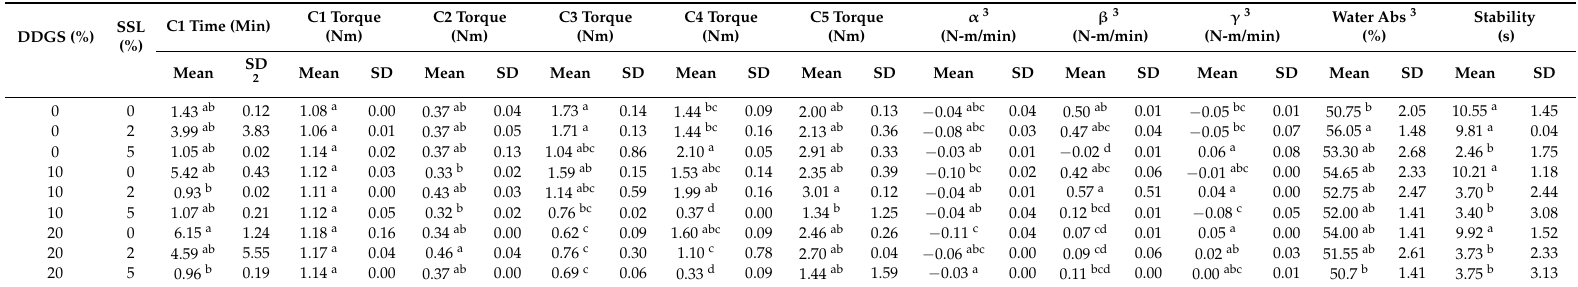
Table 8. Treatment effects on Mixolab operational parameters 1